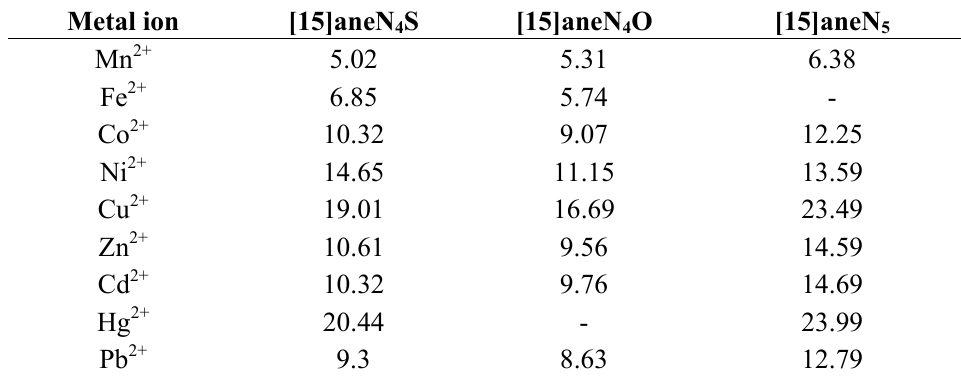
Table 3. pM values calculated for metal complexes of [15]aneN at pH 7.4 a [15]aneN 5